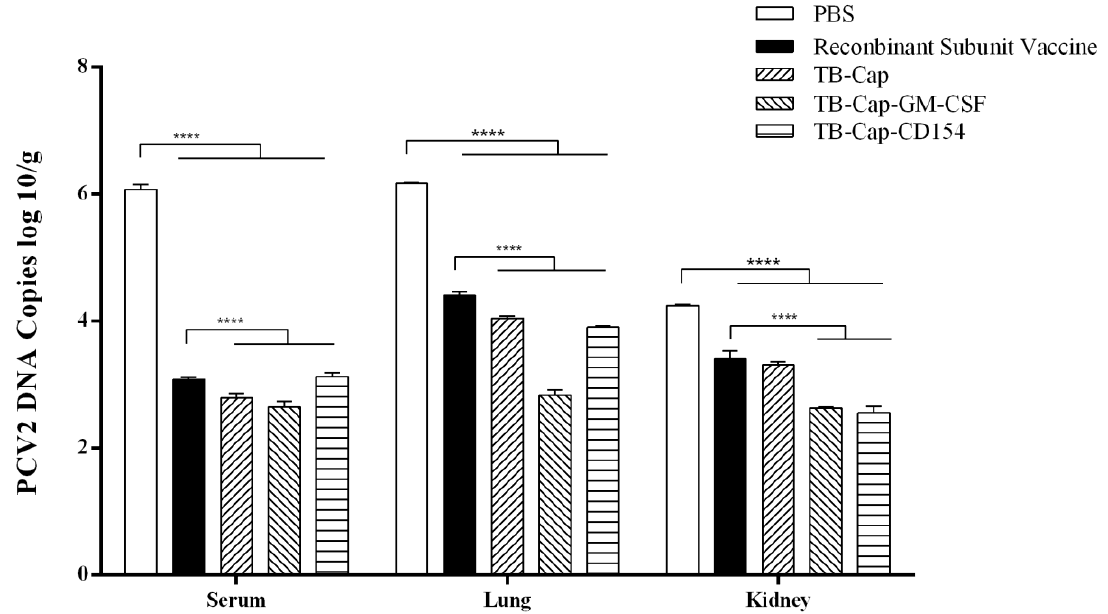
Figure 8. Detection of PCV2 viral load after challenge. On the day 42 after the first immunization, all mice in the immunization group were challenged with 1 × 10 5.7 TCID 50 PCV2. Serum, lungs and kidneys were collected and viral load was detected by real-time quantitative PCR on the day 28 after challenge. Data represent the mean ± SD. An asterisk (*) shows a statistically significant difference between the indicated groups ( p < 0.05). (*): p < 0.05; (**): p < 0.01; (***): p < 0.001; (****): p < 0.0001.